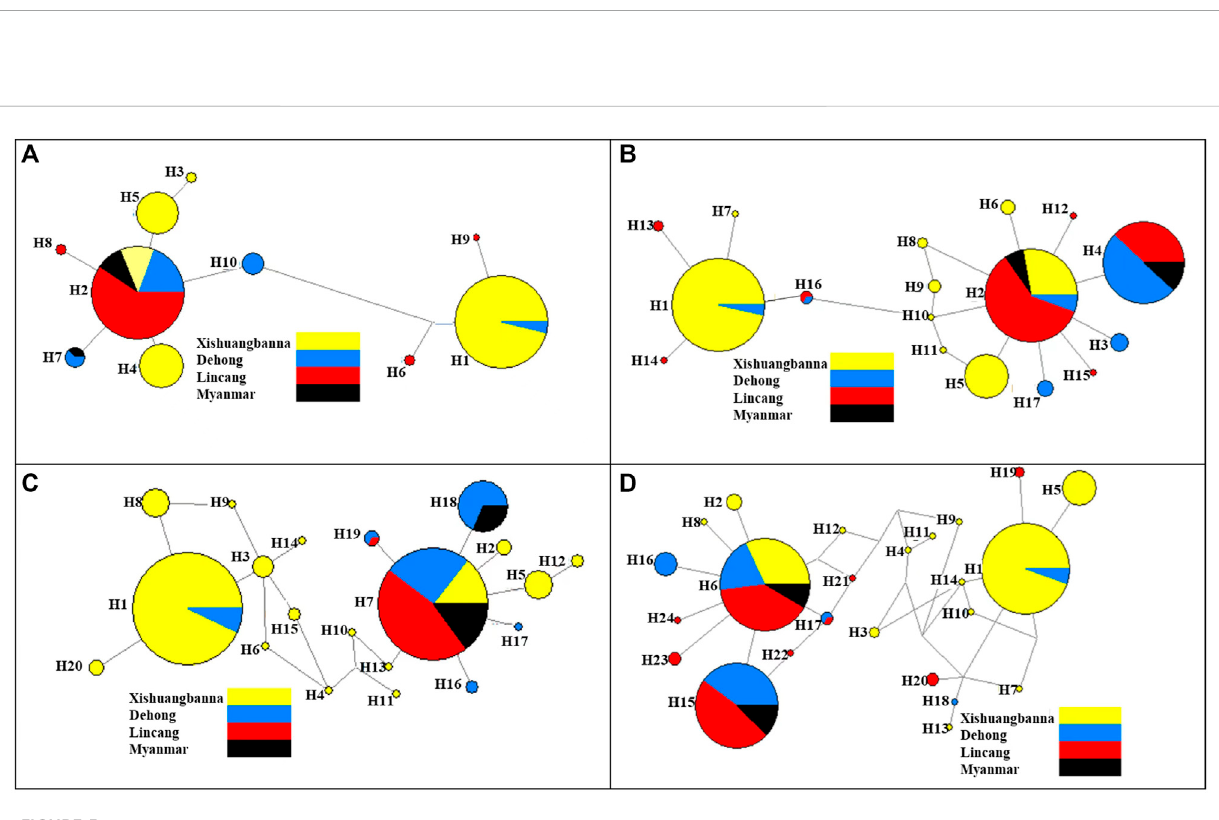
FIGURE 5 The haplotype network diagram based on COI and ND4 genes; (A) COI gene haplotype network diagram of populations in 2019; (B) ND4 gene haplotype network diagram of populations in 2019; (C) COI gene haplotype network diagram of populations in 2020; (D) ND4 gene haplotype network diagram of populations in 2020. The haplotypes of Ae. aegypti in each region are distinguished by different